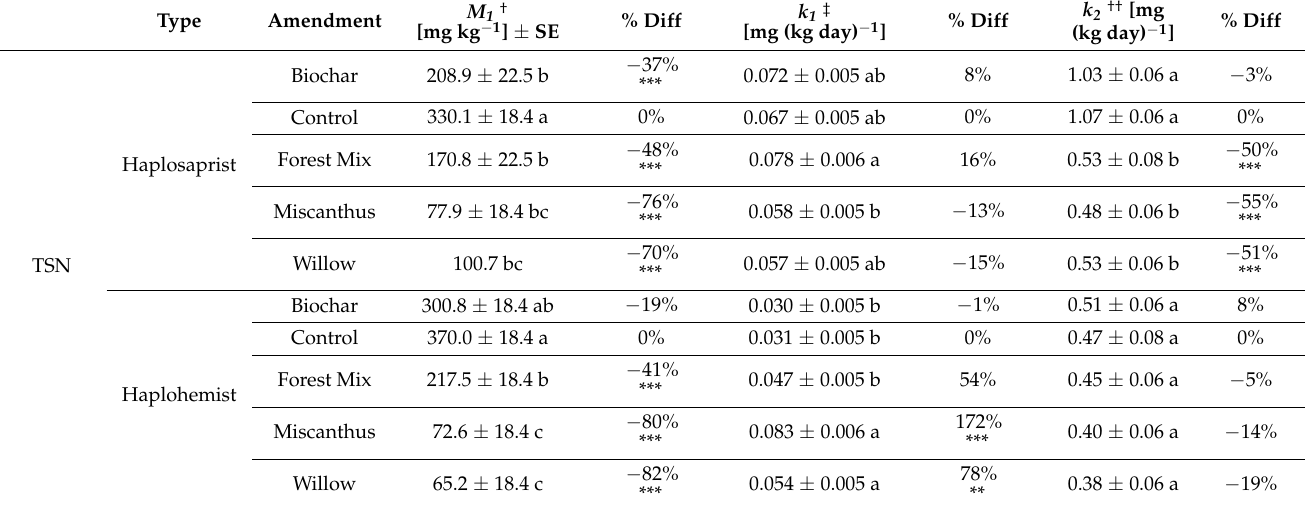
Table 3. Zero + first-order kinetic model parameters as affected by soil type and amendment for TSN and minN. Data are presented only for the two measured parameters (TSN and minN).